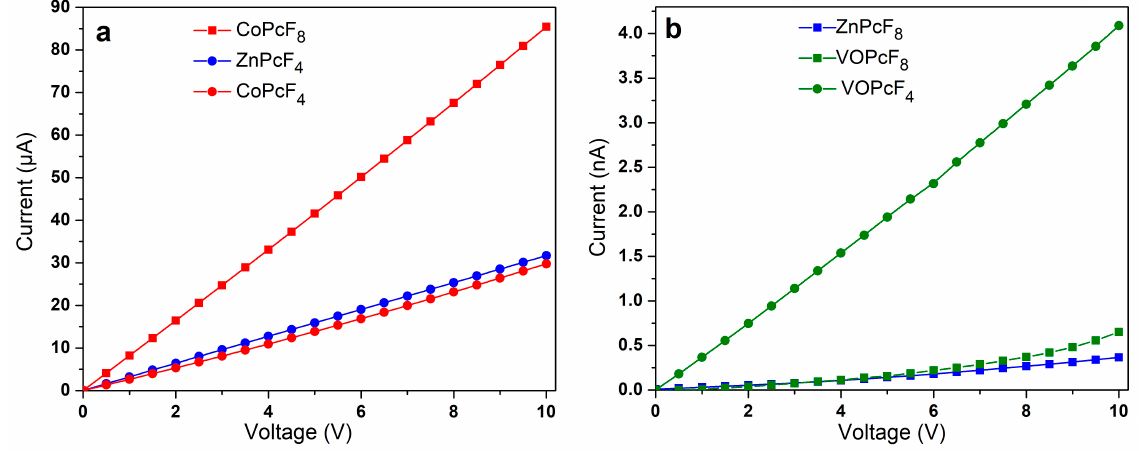
Figure 10. I(V) dependencies of CoPcF 8 ( a ) and ZnPcF 8 , VOPcF 8 ( b ) thin films in comparison with their tetrafluoro-substituted analogues CoPcF 4 -p, ZnPcF 4 -p ( a ) and VOPcF 4 -p ( b ).